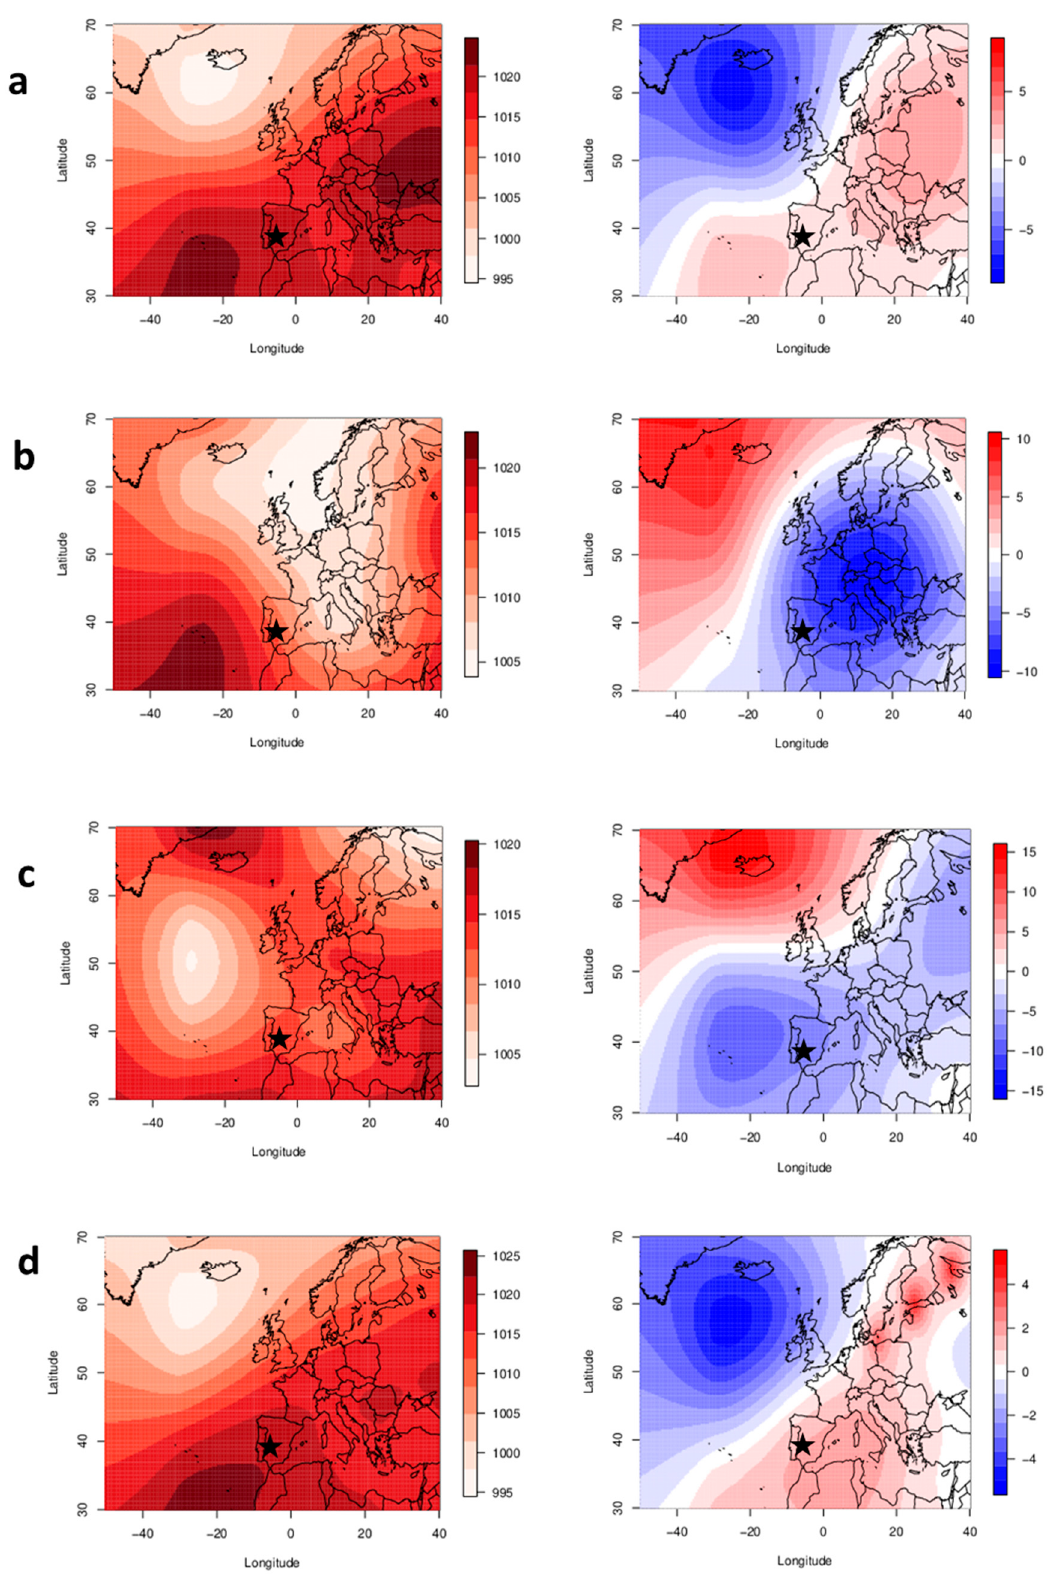
Figure 5. Monthly average of Sea Level Pressure (SLP) values, on the left, and monthly SLP anomalies, on the right, for ( a ) November 1830; ( b ) December 1830; ( c ) January 1831; ( d ) February 1831. The location of the studied region is clearly marked with a star in all maps.